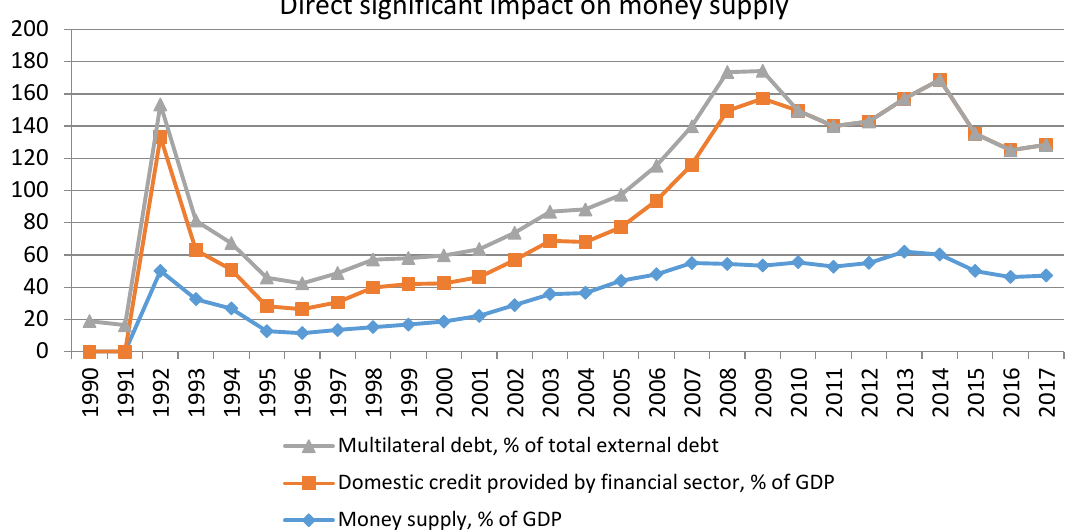
Figure 2. Direct significant impact of indicators of the national economy of Ukraine on the money supply